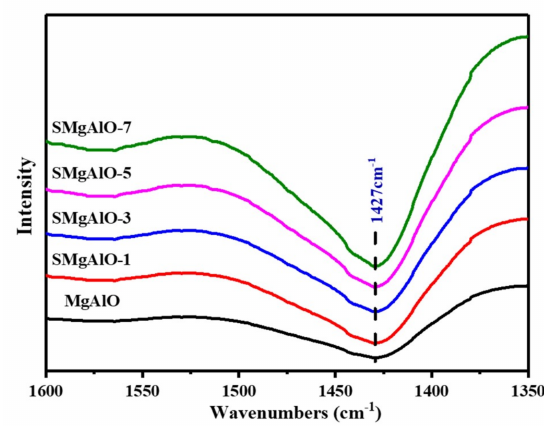
Figure 5. Py-IR analysis of MgAlO and SMgAlO-y.